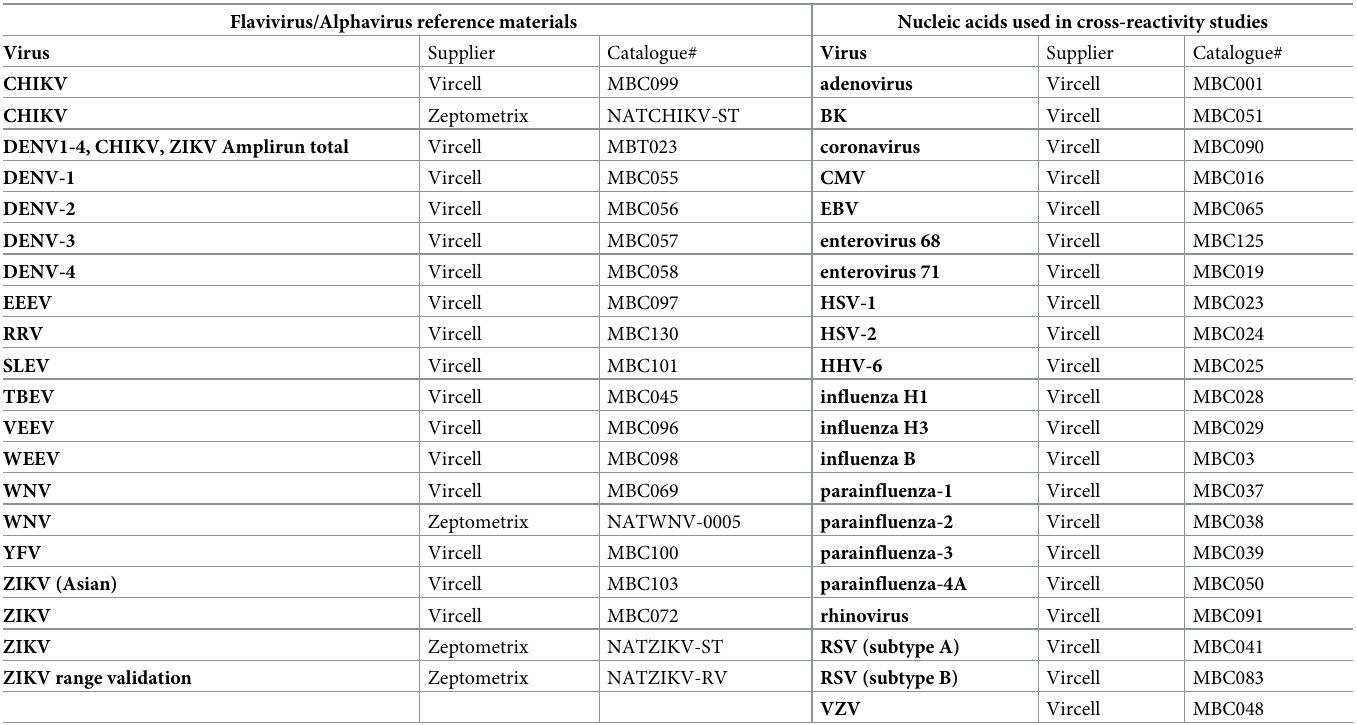
Table 2. Materials used in sensitivity/specificity